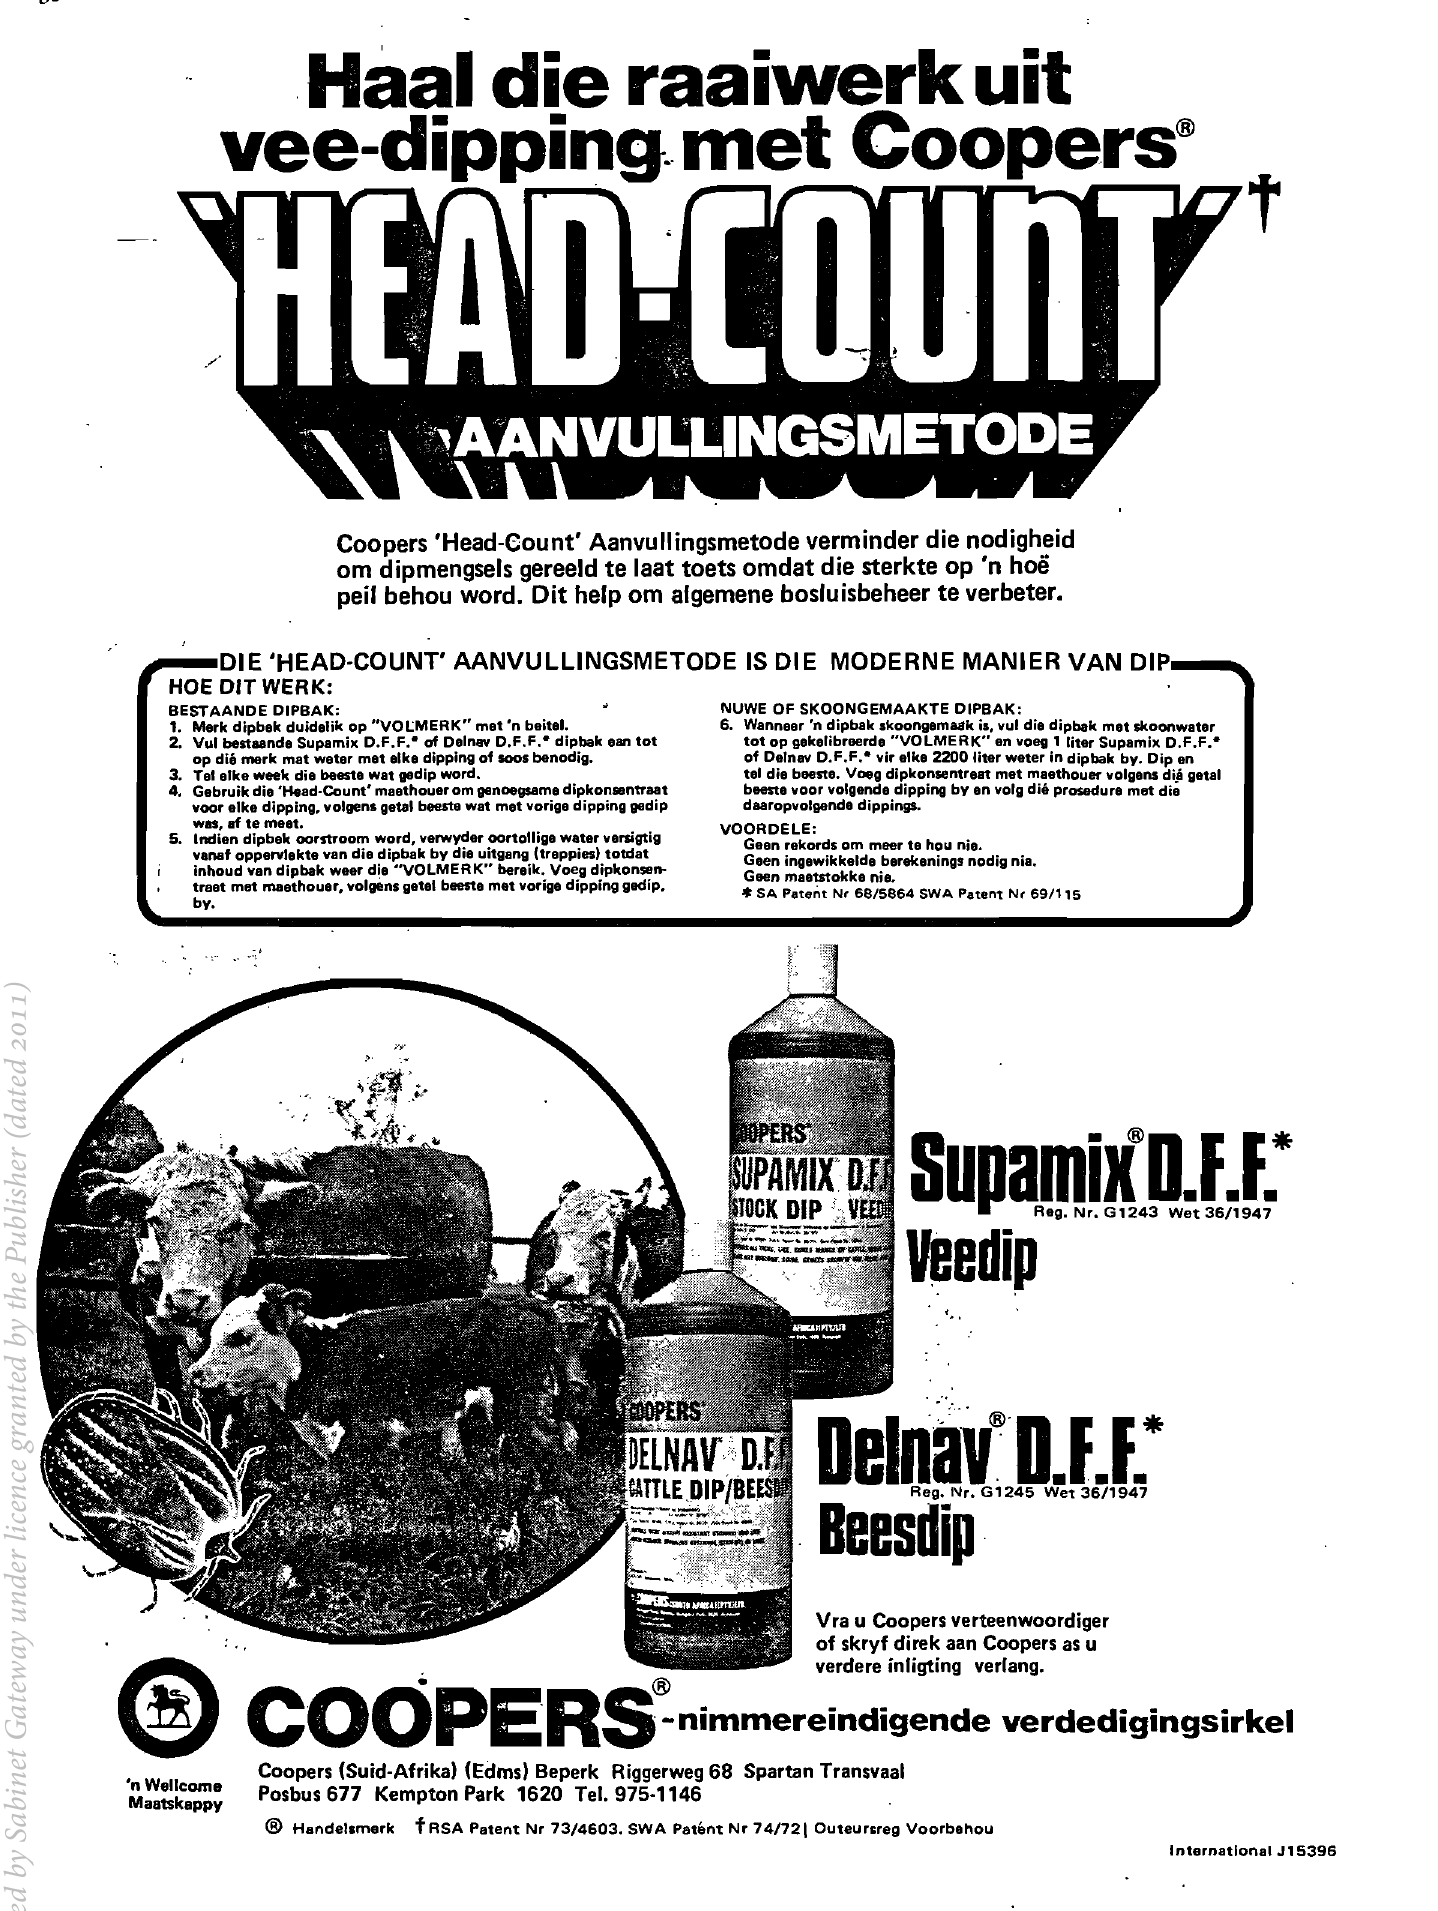
COOPERS -nimmereindigende